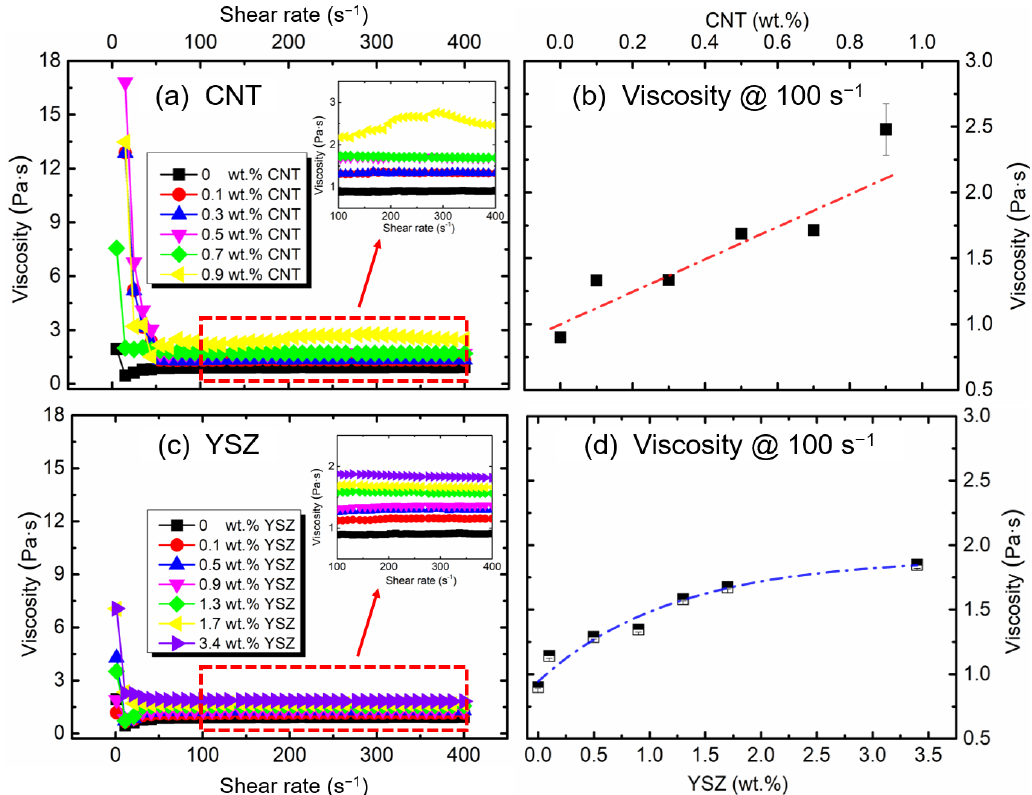
Figure 3. Rheological behaviors of slurries containing ( a ) CNT and ( c ) YSZ at various wt.% of the additives as a function of shear rate at room temperature. Comparison of viscosity of ( b ) CNT − and ( d ) YSZ − bearing resins at a constant shear rate of 100 s −1 .